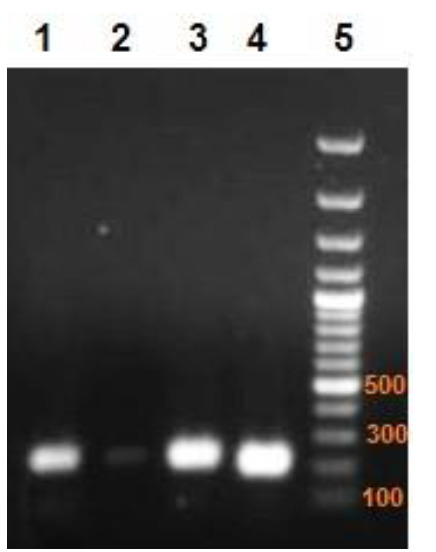
 Real-time polymerase chain reaction product electrophoresis showing the presence of complementary DNA bands; 1) Carum carvi essential oil-treated sample, 2) negative control (D.W.), 3) fluconazole-treated sample, 4) reference gene ACT1, and 5) DNA ladder (100 bp)